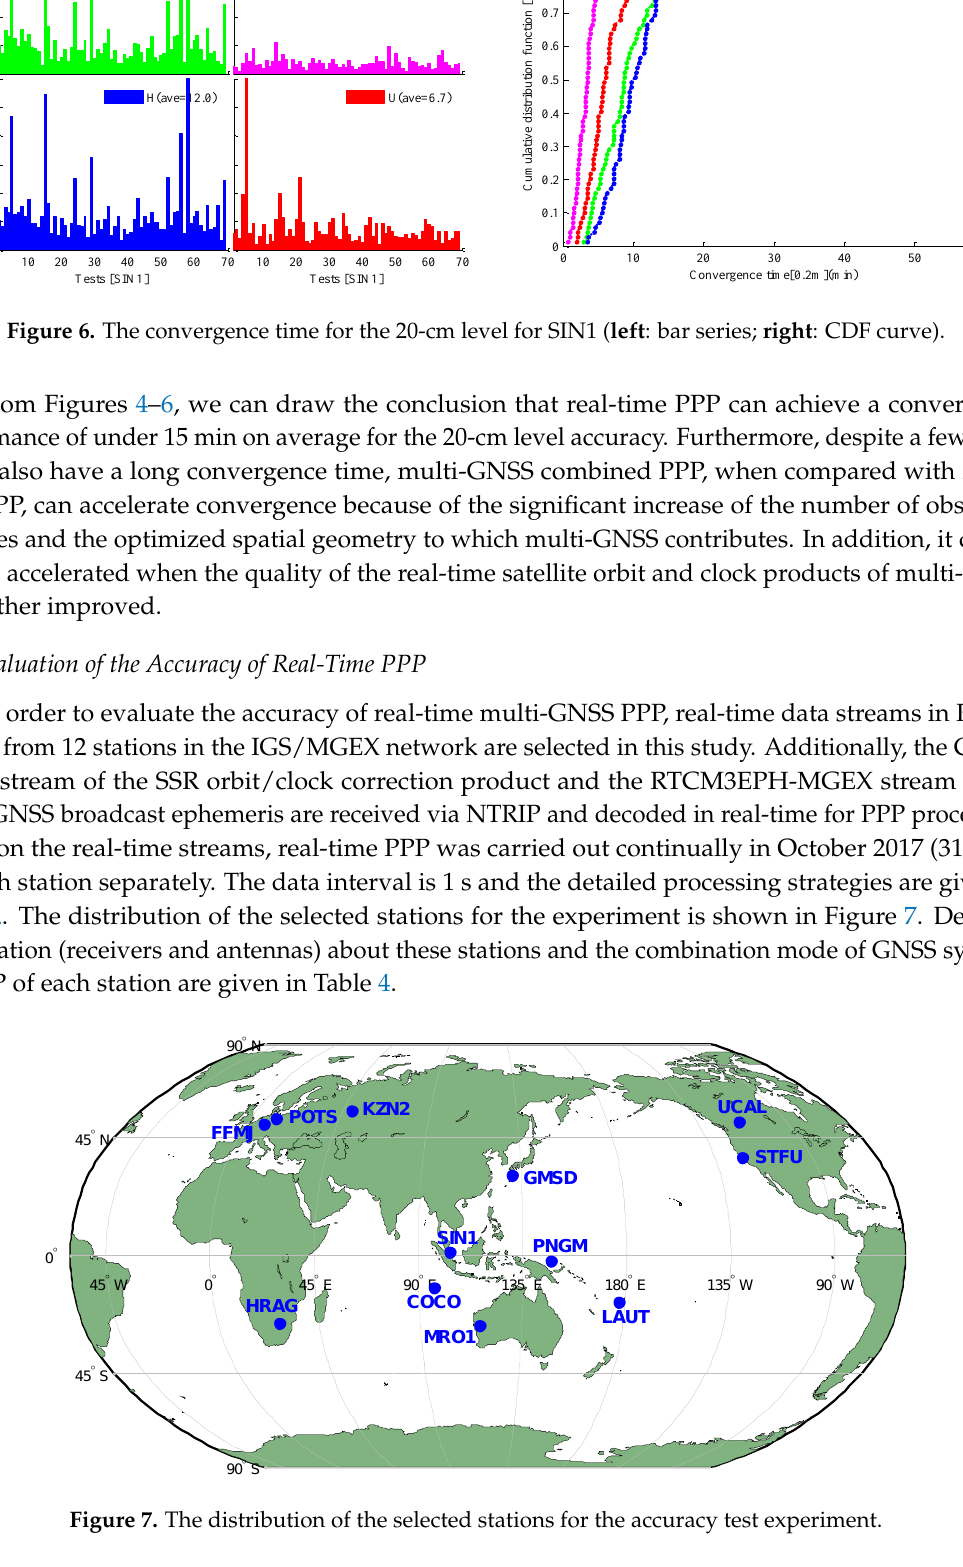
Table 4. Station information for the accuracy test of real-time PPP.